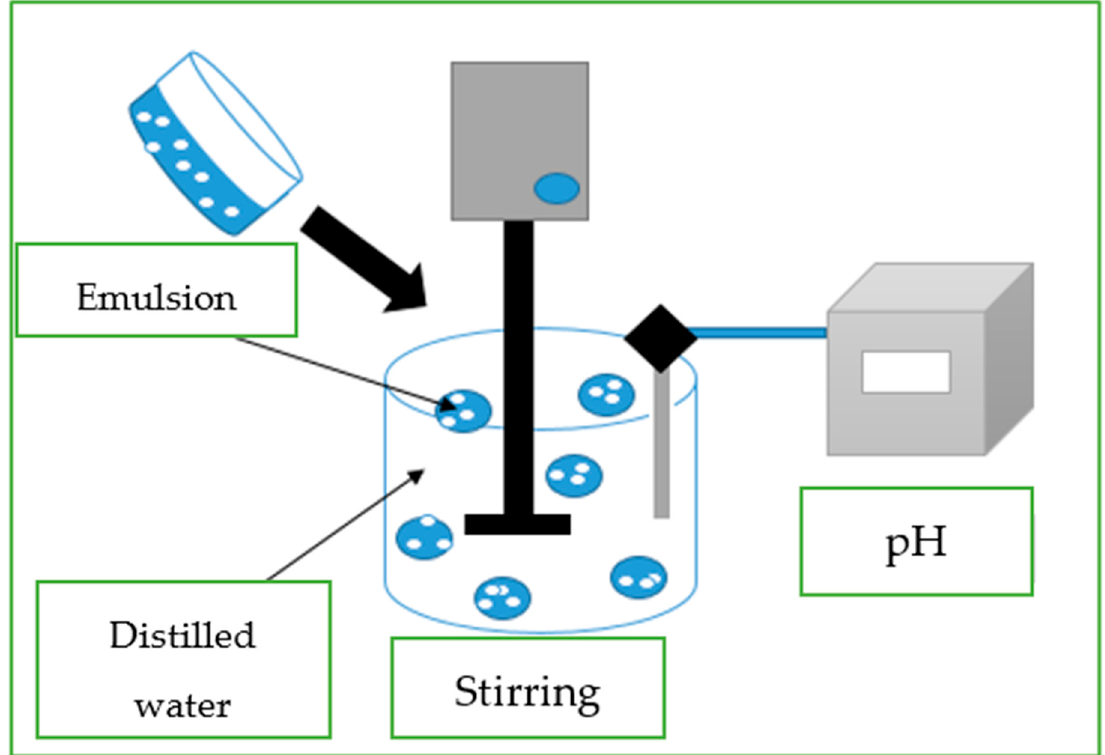
Figure 1. Emulsion preparation.